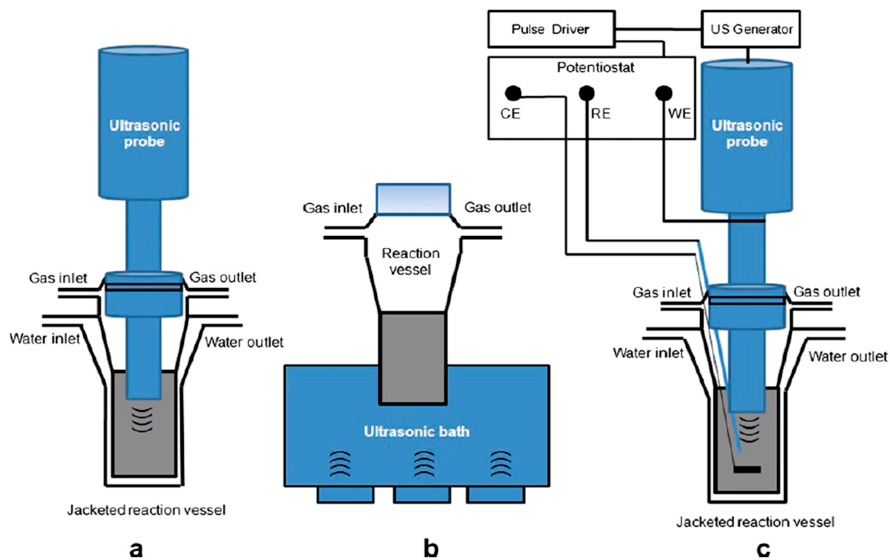
Figure 7. Sonochemical (( a ) ultrasonic probe setup; ( b ) ultrasonic bath setup) and sonoelectrochemical (( c ) ultrasonic probe used as the vibrating cathode) to prepare Proton Exchange Membrane Fuel Cell (PEMFC), Direct Methanol Fuel Cell (DMFC), and Proton Exchange Membrane Water Electrolyzer (PEMWE) electrocatalyst nanoparticles [15]. CE: Counter Electrode, RE: Reference Electrode, WE: Working